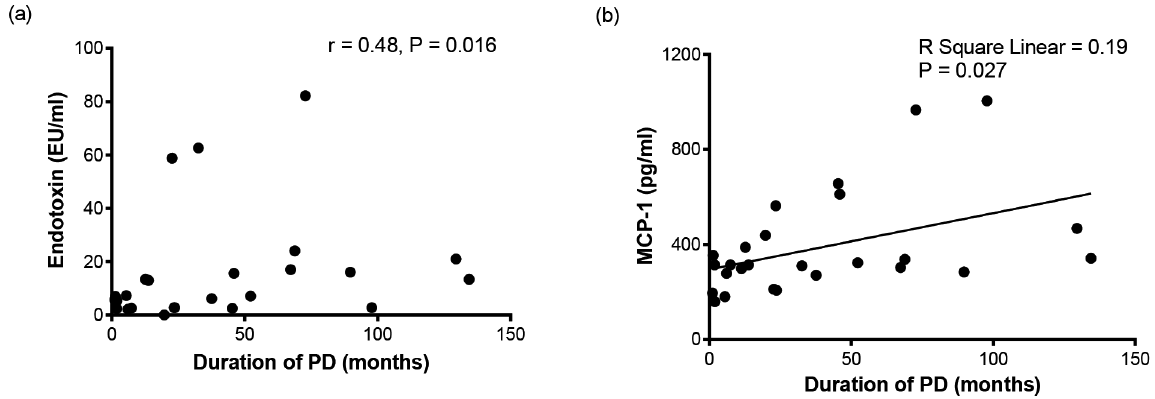
Figure 1. Correlations between the duration of peritoneal dialysis and serum endotoxin (a) and serum MCP-1 (b). A positive association between the duration of PD and serum endotoxin (a) and linear association between the duration of PD and serum monocyte chemoattractant protein-1 (b) levels in patients on CAPD.